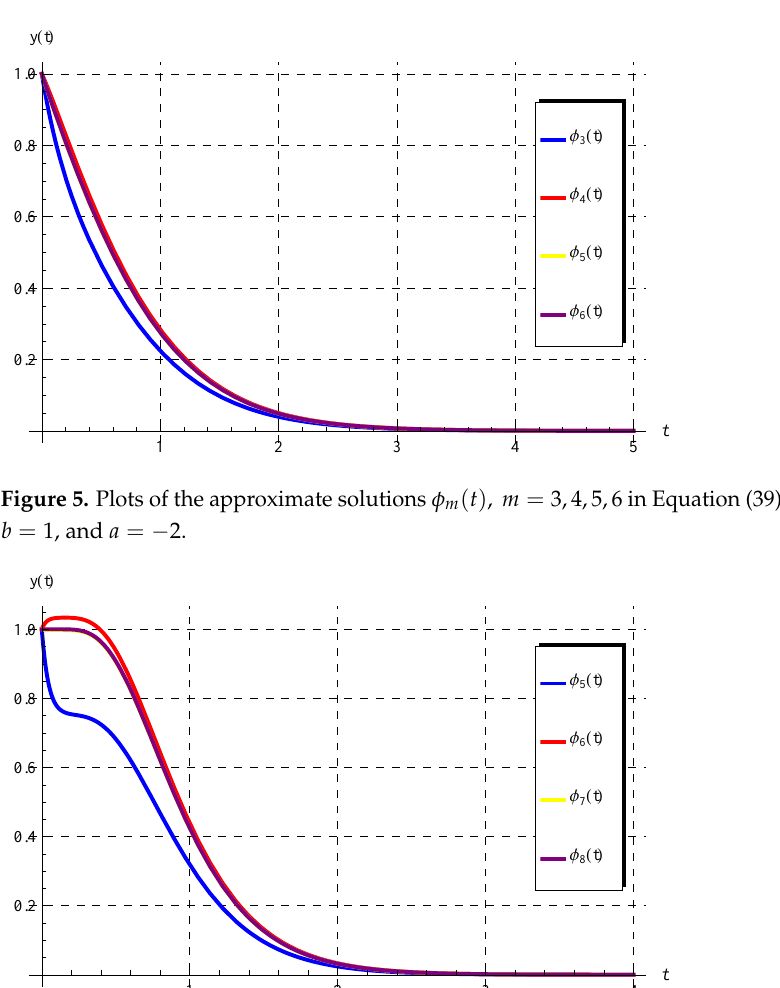
Figure 6. Plots of the approximate solutions φ m ( t ) , m = 5,6,7,8 in Equation (39) vs. t at λ = 1, c = 3 b = 3, and a = −